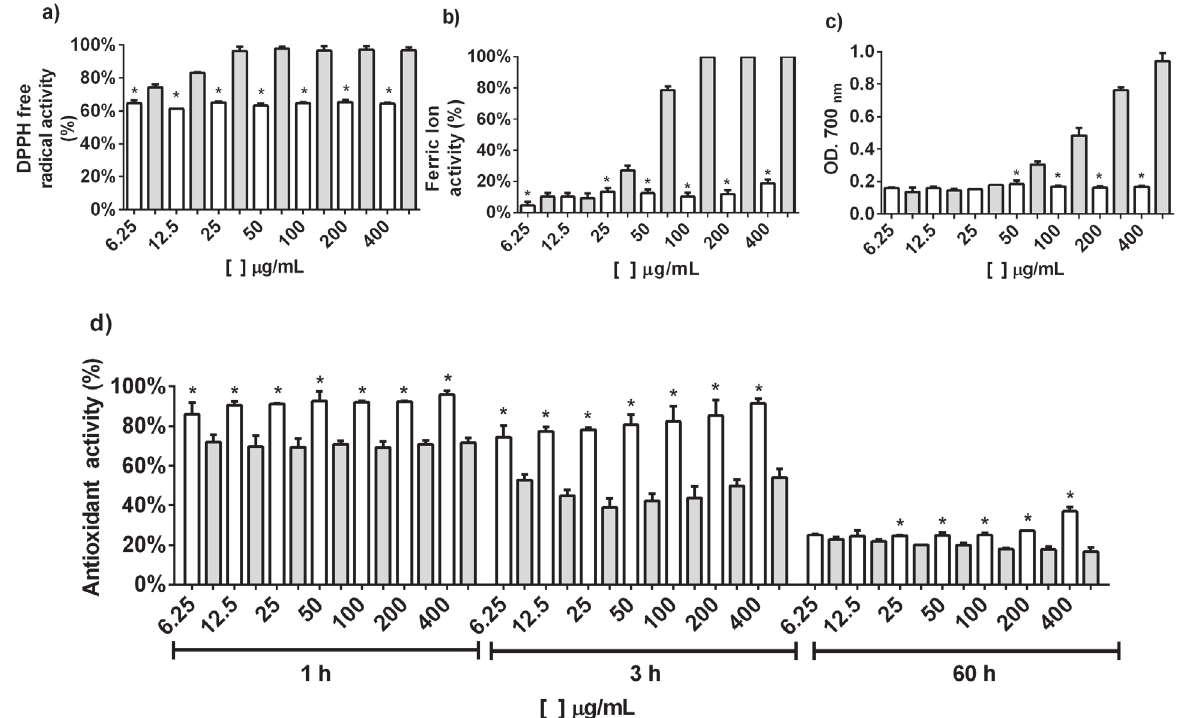
Figure 3 - Antioxidant activity of the essential oil from Myroxylon peruiferum l.f. Test DPPH ( a ), FRAP ( b ), FIC ( c ) and BCB ( d ). White column: sample; Gray column: positive control.* Statistically significant in relation to the positive control, when p <